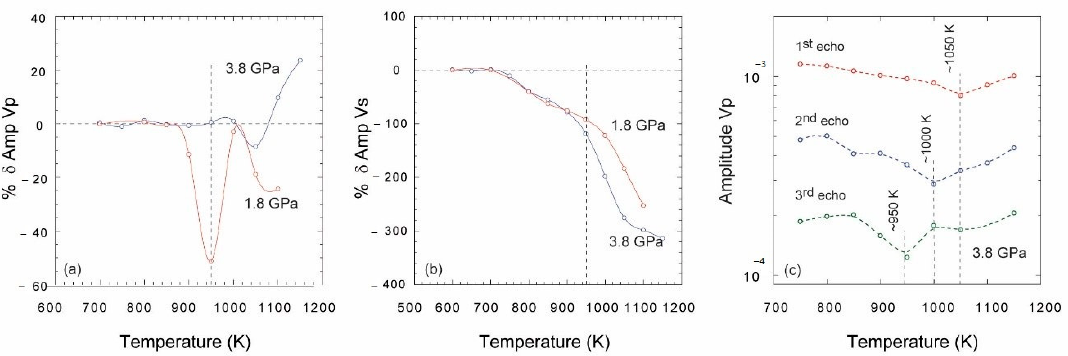
Figure 6. The% change of amplitude of P- ( a ) and S- ( b ) waves relative to the amplitude for the chlorite before dehydration. Blue and red lines are for 1.8 and 3.8 GPa respectively. The vertical dashed line indicates the dehydration temperature observed for chlorite. ( c ) The change of amplitudes in the 1st, 2nd, and 3rd echos of the P-waves at 3.8 GPa. The blue and red lines in panels ( a ) and ( b ) are the cubic-spline fits through data points.